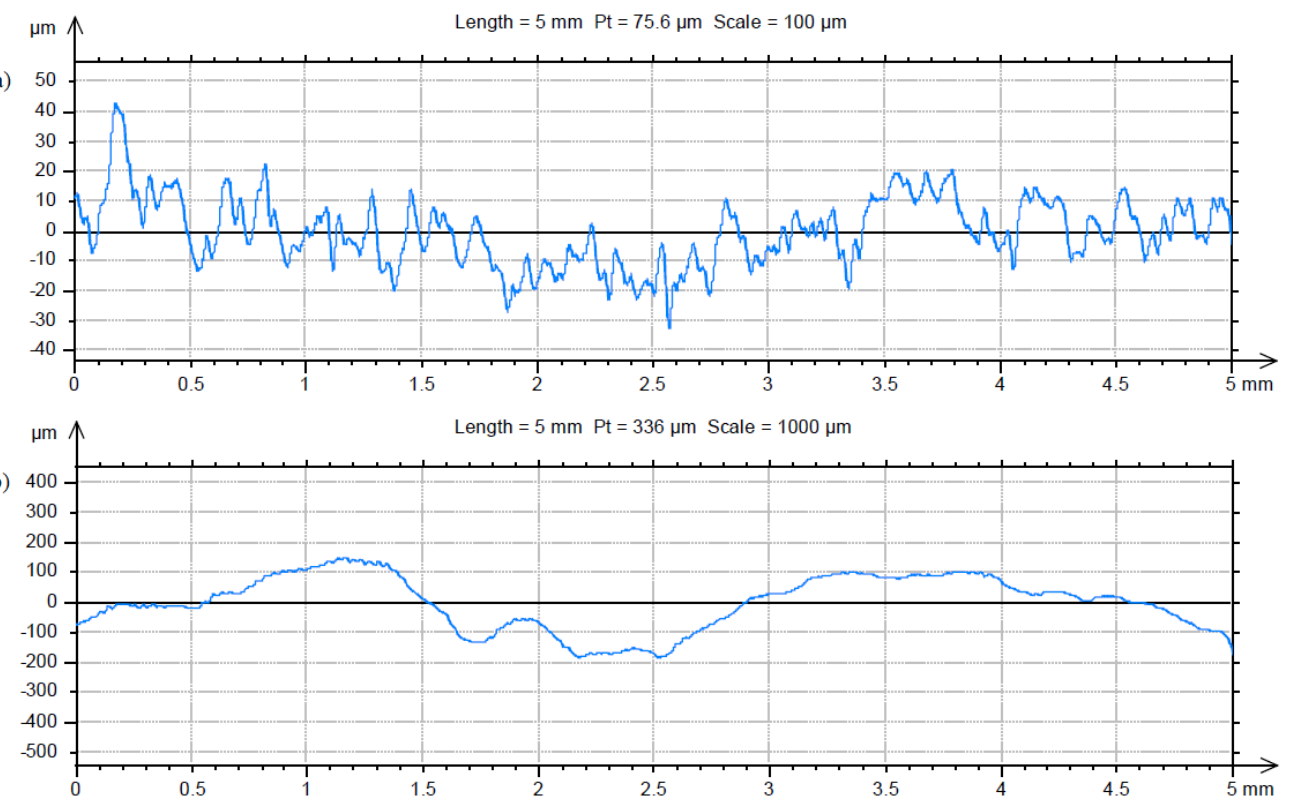
Figure 7. Representative profile lines for the sterile coupon ( a ) and coupon with biofilm ( b ).